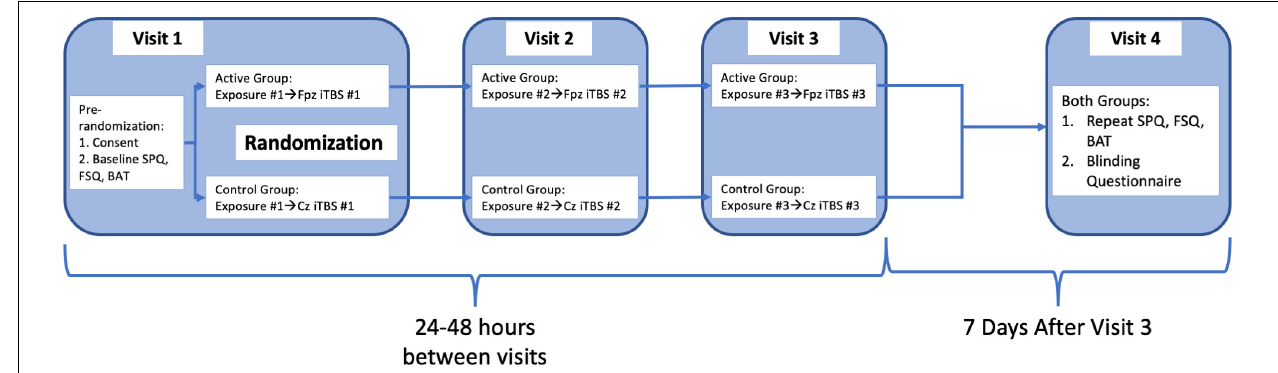
FIGURE 1 | Graphical representation of procedural flow of study steps as detailed in the section